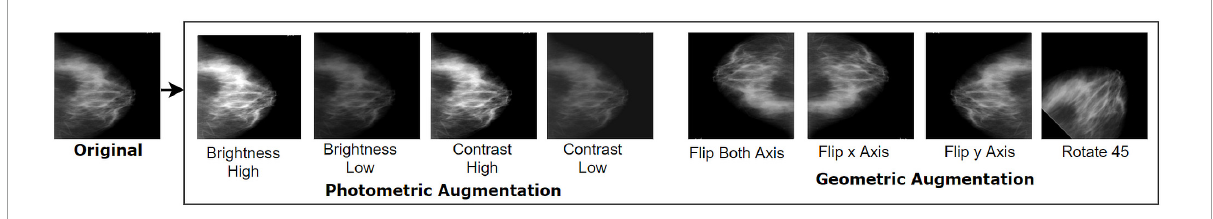
FIGURE4 Geometric and photometric augmentation